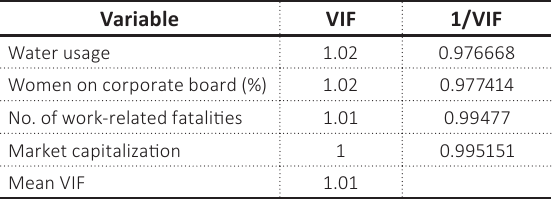
Table 4. Multicollinearity test